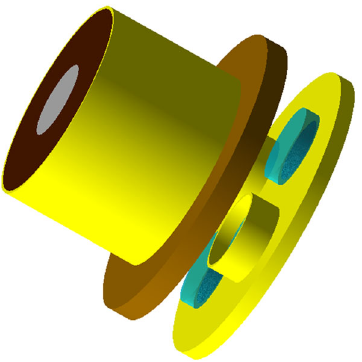
Fig. 7 TheexperimentalsetupmodelledinGeant4,includingtheTPC- cathode made of copper, aluminum-deposited radioactive source, cylin- drical teflon reflector, MWPC frames, and the four PMs supported in a teflon frame